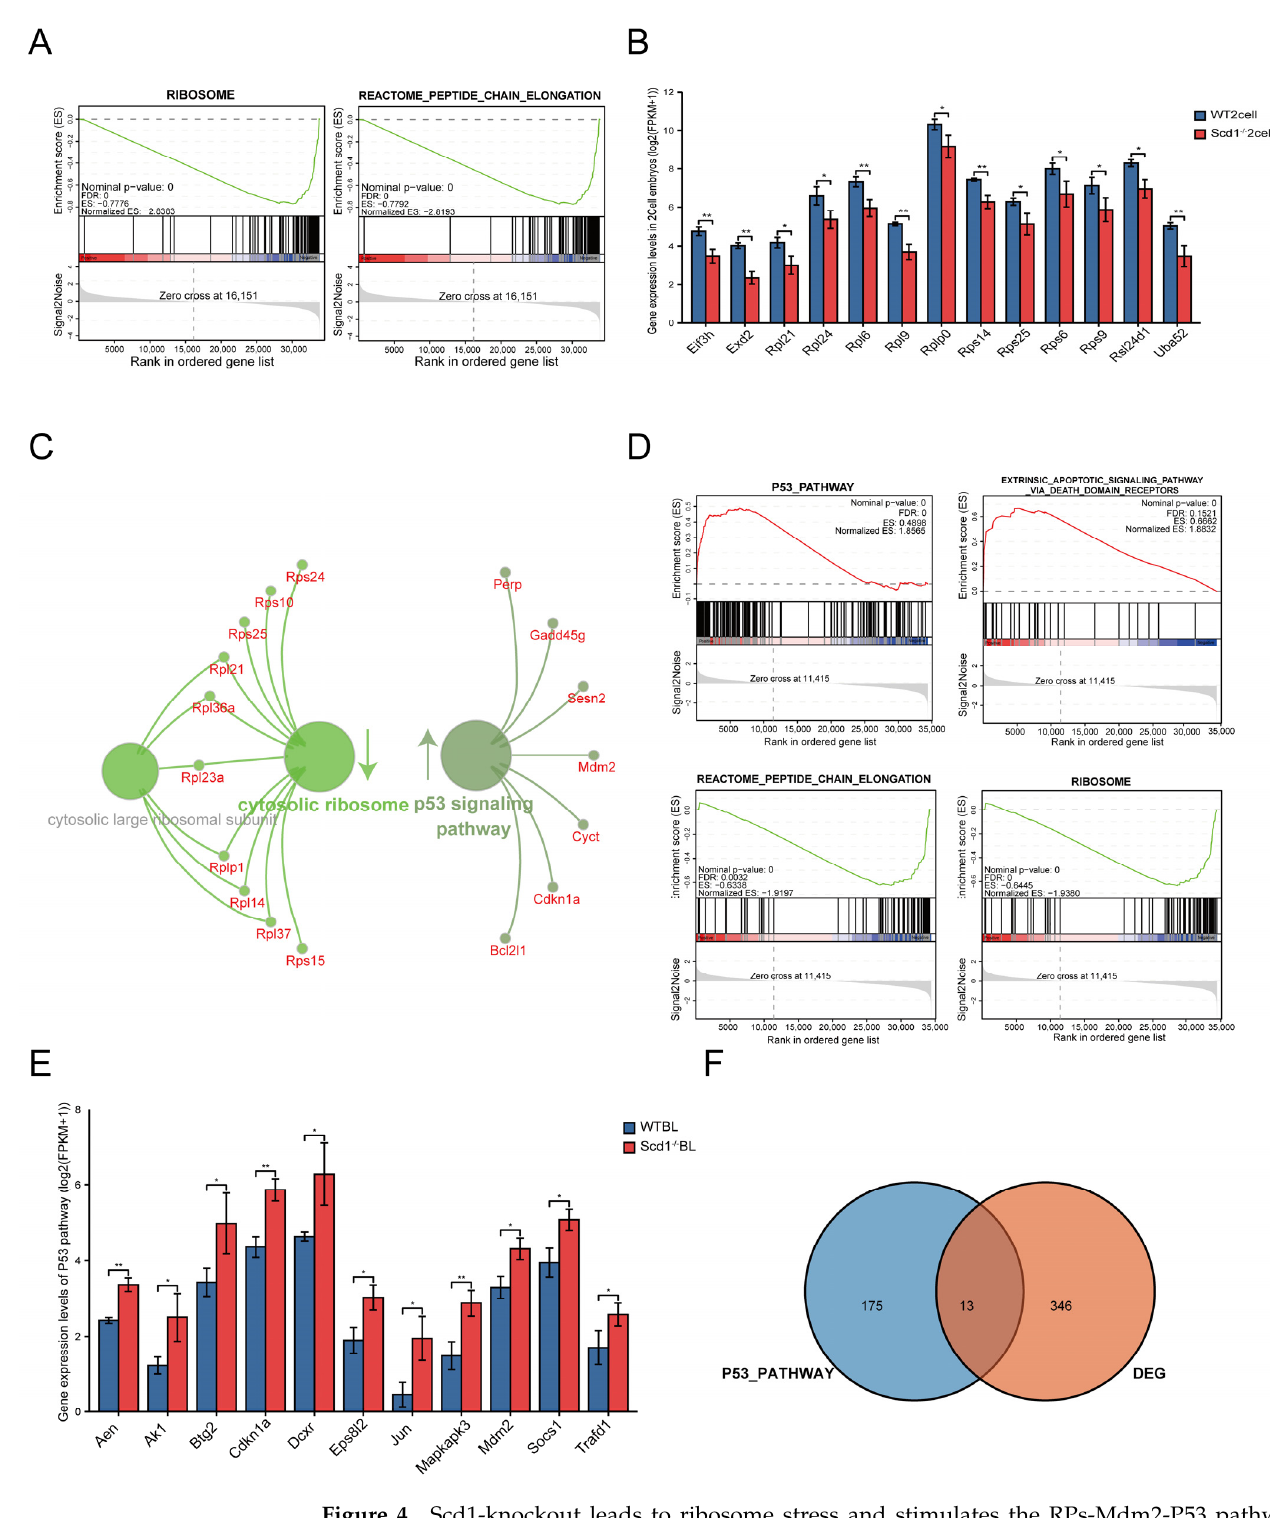
Figure 4. Scd1-knockout leads to ribosome stress and stimulates the RPs-Mdm2-P53 pathway. ( A ): The GSEA result for the Scd1 − / − versus WT embryos at 2-cell stage. ( B ): Genes related to ribosome biogenesis process were downregulated significantly in Scd1 − / − 2 cell stage embryos. ( C ): Functional enrichment analysis of differential genes between Scd1 − / − and WT embryos at blastocyst stage. ( D ): The GSEA result for the two groups’ embryos in blastocyst stage. ( E ): The expression levels of DEGs related to P53 pathway at blastocyst stage. * p < 0.05; ** p < 0.01. ( F ): Venn diagram of 13 genes in both DEGs and P53 pathway at blastocyst